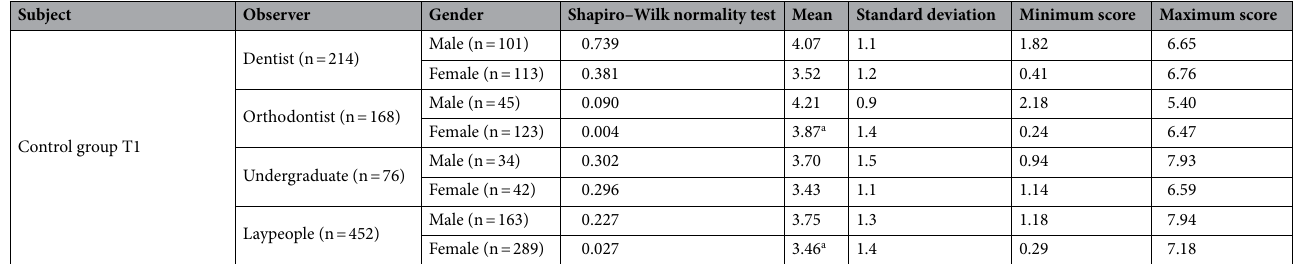
Table 2. Descriptive statistics for the overall VAS scores, divided by the observer’s expertise. a Non-normal distribution according to the Shapiro–Wilk normality test. To improve the readablity of the results, for each observer a mean value of all the scores submitted for each group at T0 and T1 was used to calculate the present descriptive statistics.